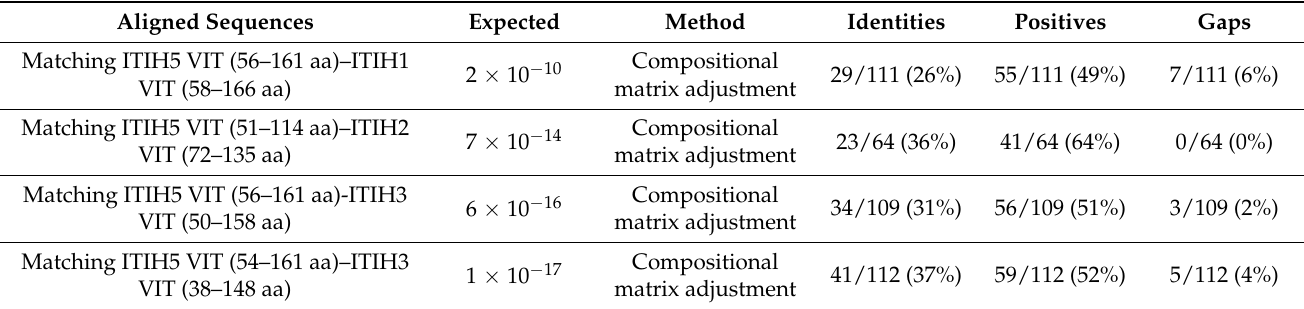
Table 1. Alignment statistics for the ITIH5-derived VIT sequence (ITIH5 161aa